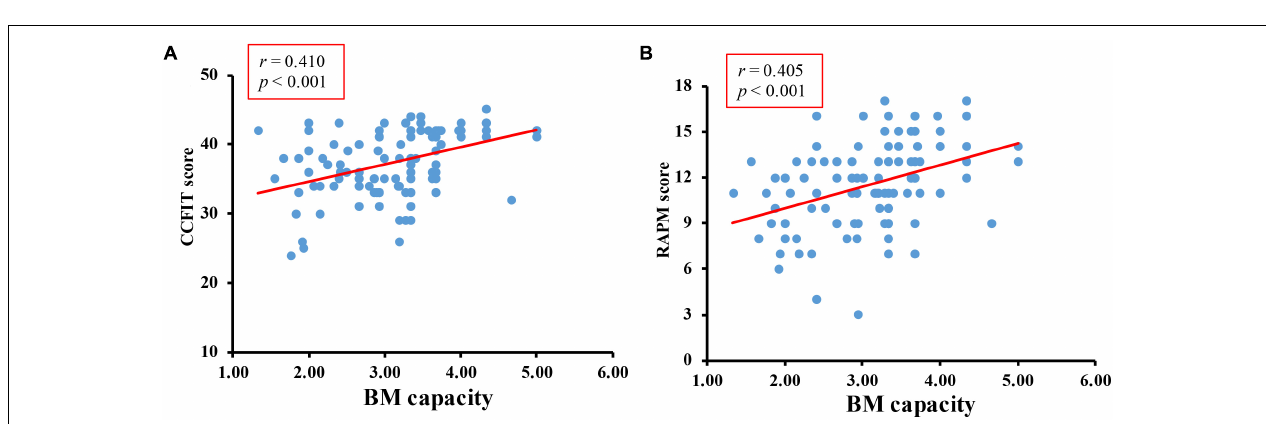
FIGURE 2 | Results of Pilot study. (A) The correlation between BM-WM capacity and CCFIT. (B) The correlation between BM-WM capacity and RAPM.